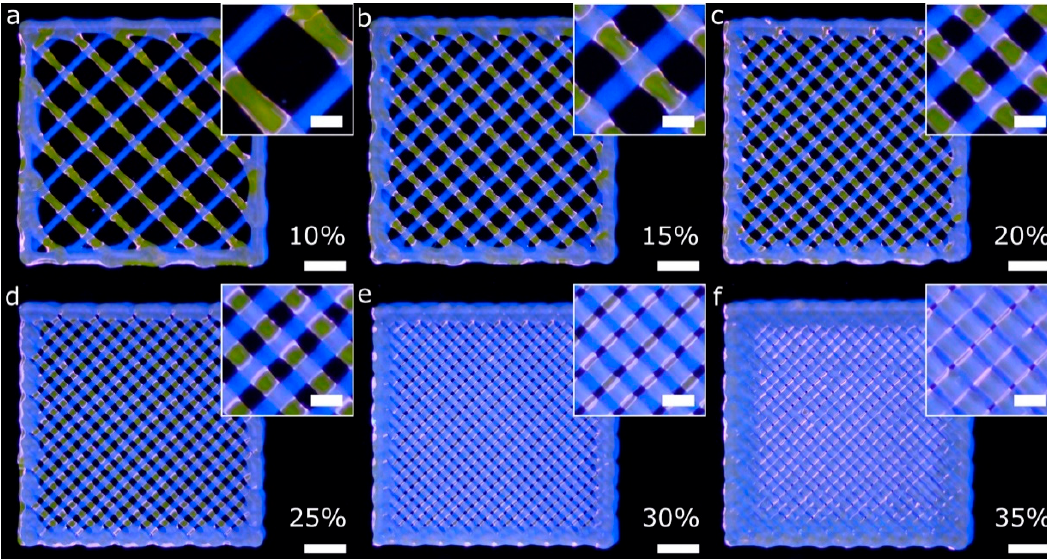
Figure 10. General and detailed views of porous lattice structures printed with two bioinks and two printheads. Each bioink was used in a different layer. The G-code was generated using the slicing software with the infill percentages: 10% ( a ), 15% ( b ), 20% ( c ), 25% ( d ), 30% ( e ) and 35% ( f ). The printing pressure and speed utilized in all the cases were 16 psi and 15 mm s − 1 , respectively; scale bars: 2 mm (general views) and 500 μ m (detailed views).